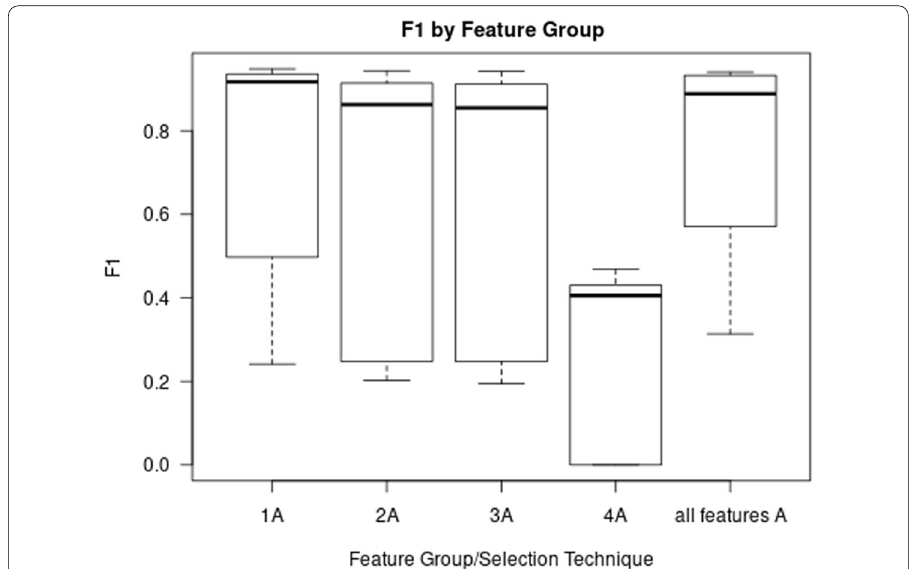
Fig. 4 Box plots of F1-score grouped by feature group/selection technique; here datasets do not include destination port; Tukey’s HSD test indicates all features A in group a, 1A in group b, 2A in group c, 3A in